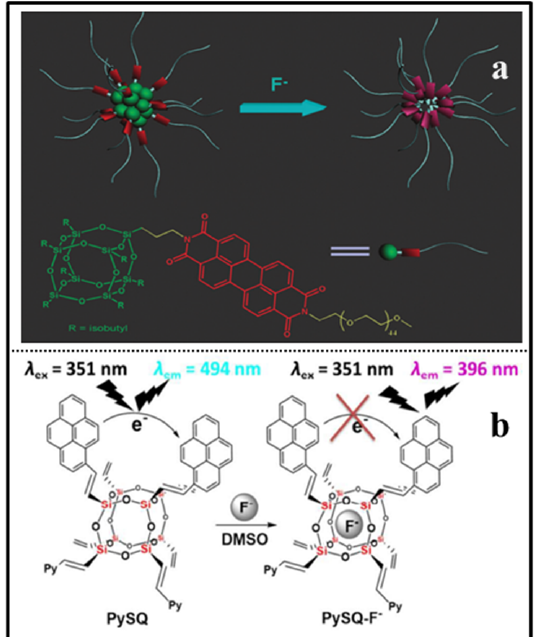
Figure 19. ( a ) Schematic representation of NP structure self-assembled from the POSSPBI-PEO and fluoride ion sensing process in water [98]. ( b ) Schematic representation of PySQ for fluoride ion sensing process in DMSO [27].